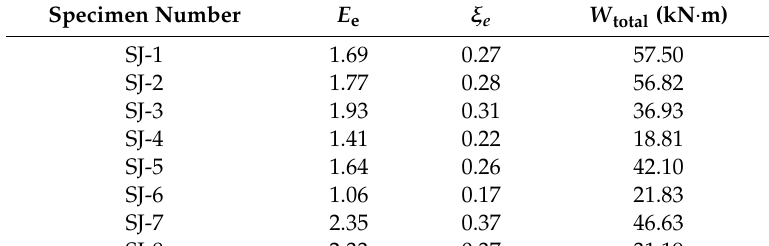
Table 5. Energy dissipation parameters of the specimens in the limit state.